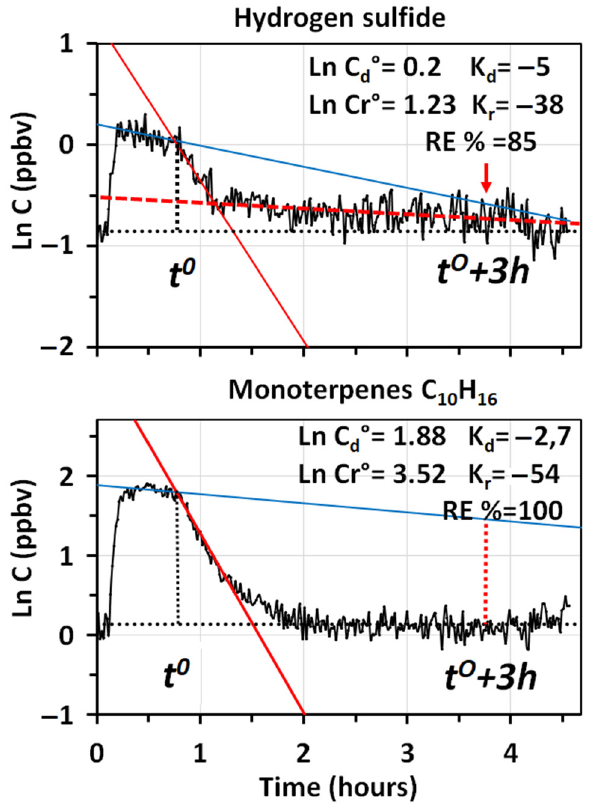
Figure 13. Semi-logarithmic plots of H 2 S and total monoterpenes obtained in an experiment using cigarette smoke and the SANINDOOR prototype as an air cleaner. The meaning of the solid lines in blue and red is the same as in the previous two figures. The net amount removed by the cleaner has been calculated after 3 h of cleaning, as in Figure 9, and it is indicated by the vertical dotted segments in red.